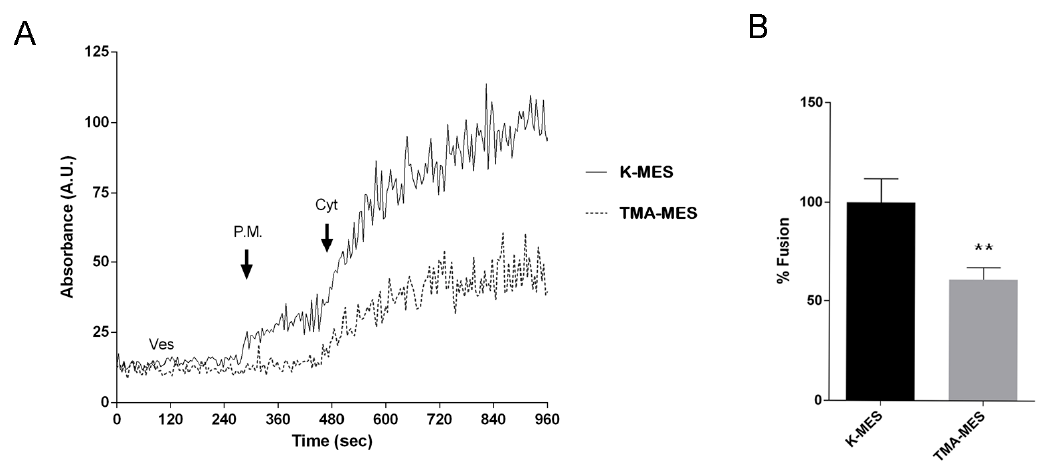
Figure 8. Membrane fusion assay. ( A ) Time course of fluorescence signal of AQP2 vesicles labelled with R18 and incubated with unlabelled plasma membrane after addition of cytosol. Effect of K+ chemical gradient on membrane fusion. Representative curves are shown. ( B ) Statistical analysis of fluorescence signal was calculated as a delta between 120 and 840 s. Statistical analysis was performed by One-way ANOVA. Compared with K-MES (fusion obtained after cytosol addition) the fusion between vesicles and plasma membrane was significantly decreased by about 40% in the absence of K + gradient (TMA-MES). All values are reported as means ± S.E.Ms. ** p =0.007.